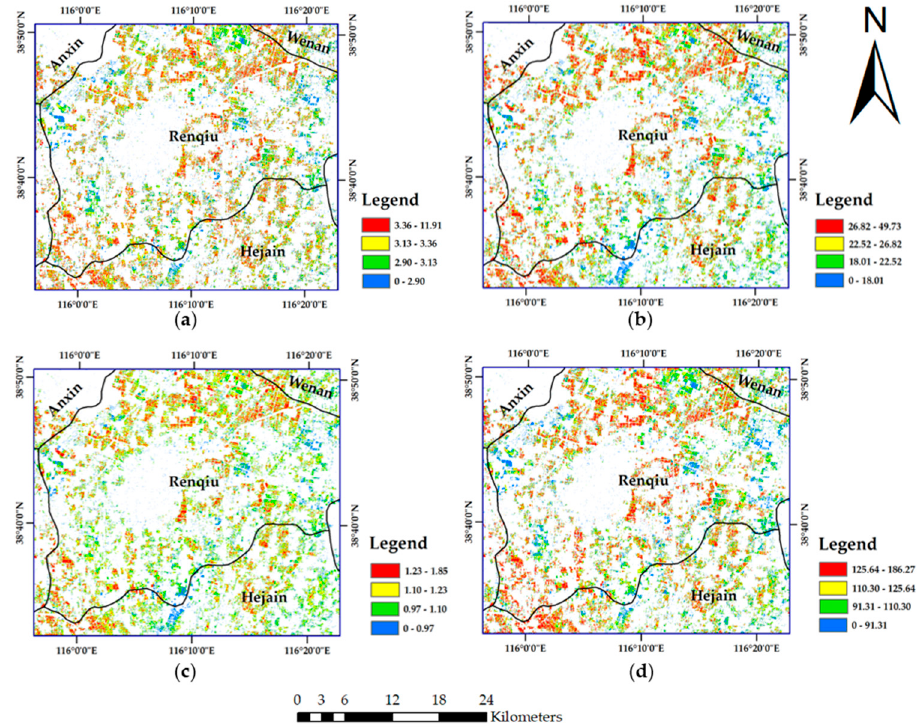
Figure 11. Spatial distribution map of the four nitrogen nutrition indexes. ( a ) LNC spatial distribution map. ( b ) LNA spatial distribution map. ( c ) PNC spatial distribution map. ( d ) PNA spatial distribution map.